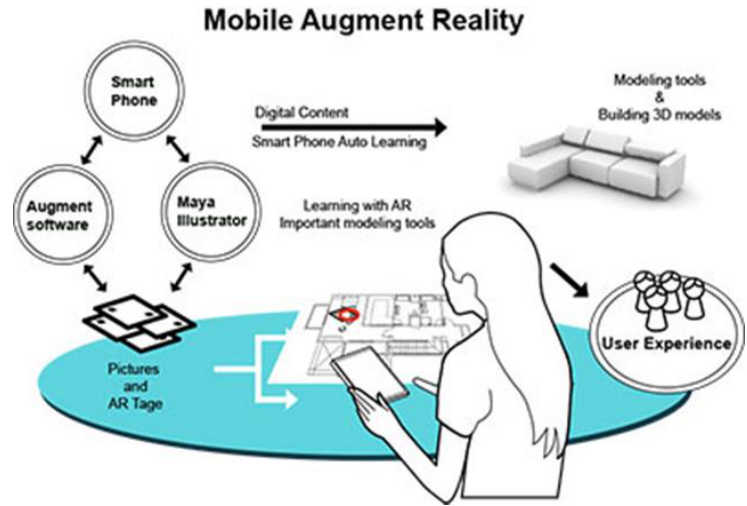
Figure 2. Overview of our system solution. Based on an interior layout plan, we create an augmented reality (AR) scene on mobile devices. Interior design symbols as e.g., chairs, tables, couches are converted to augmented artefacts and overlay the physical world.